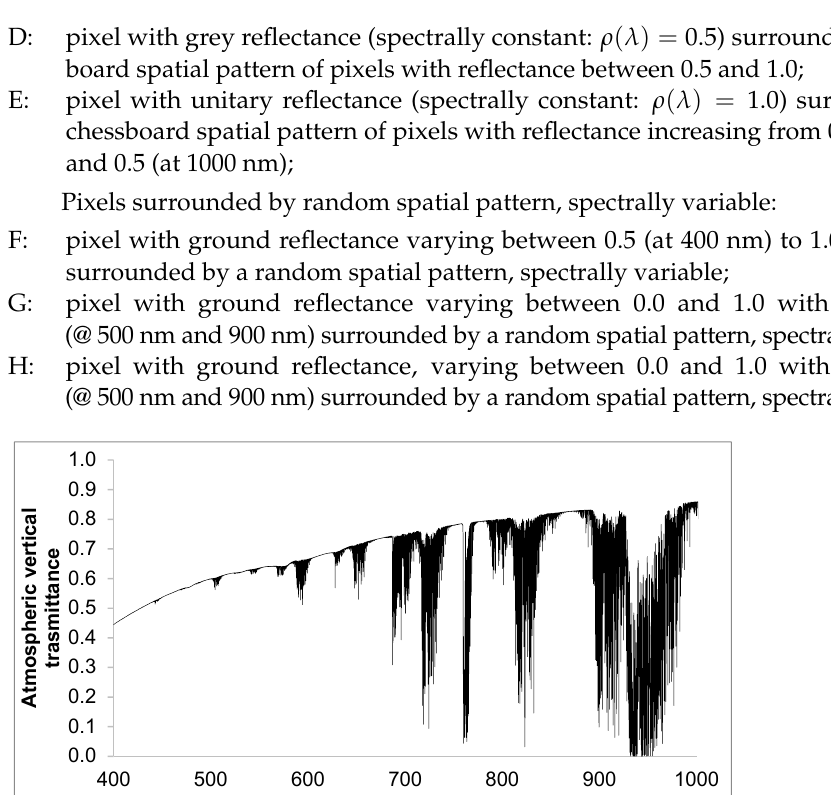
Figure 2 . Vertical transmittance of the atmosphere used for the simulation. Figure 2. Vertical transmittance of the atmosphere used for the simulation. 10 pixel reflectance patterns. The dots in Figure 3 show the pixel position for which the